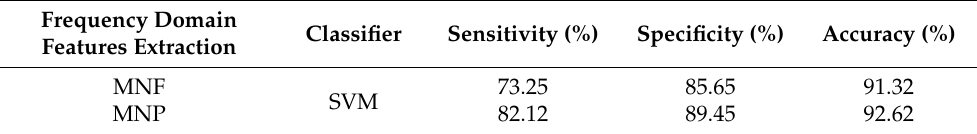
Table 5. Classification performance indices with the MNF and MNP features.